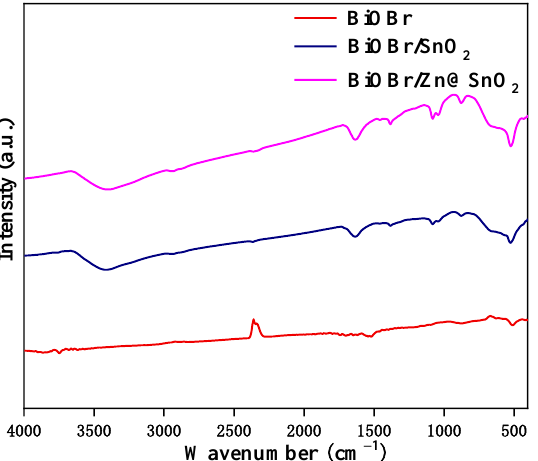
Figure 2. FT-IR spectra of BiOBr, BiOBr/SnO 2 , BiOBr/Zn@SnO 2 . 21.91 ◦ , 25.20 ◦ , 31.73 ◦ , 32.20 ◦ , 39.31 ◦ , 46.21 ◦ , 50.66 ◦ , 53.35 ◦ and 57.17 ◦ corresponding